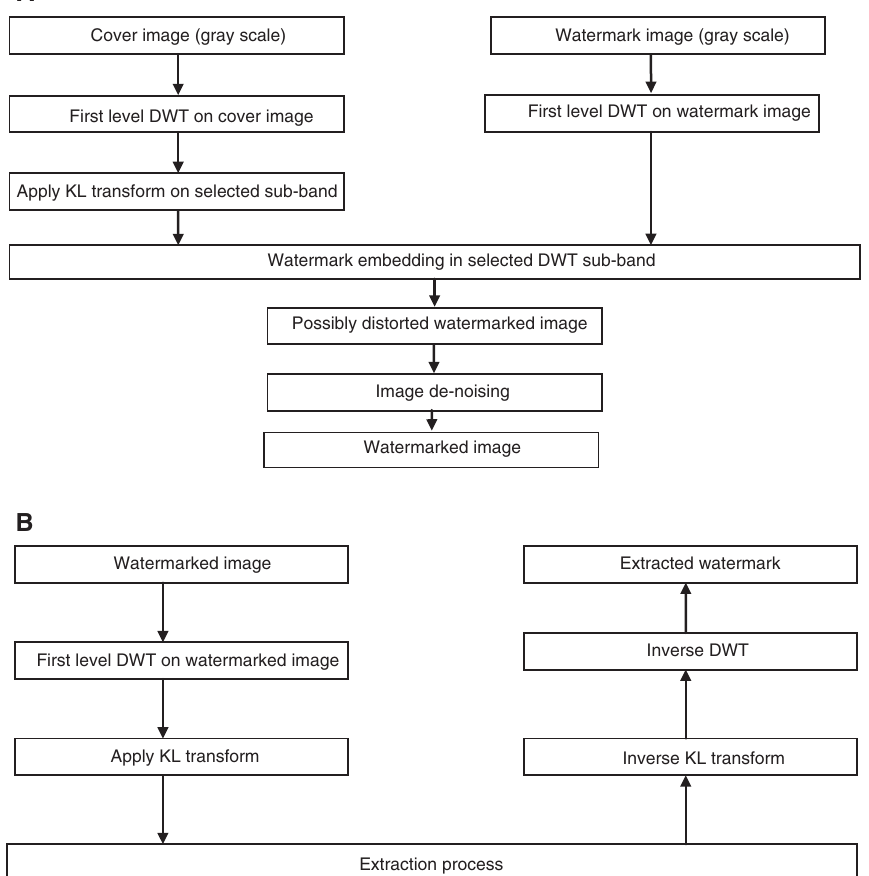
Figure 2: Watermark (A) Embedding and (B) Extraction Process.